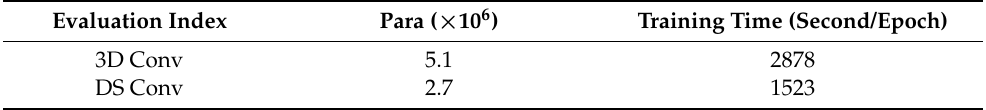
Table 7. Comparison of the global network parameters and training time for different convolutions.